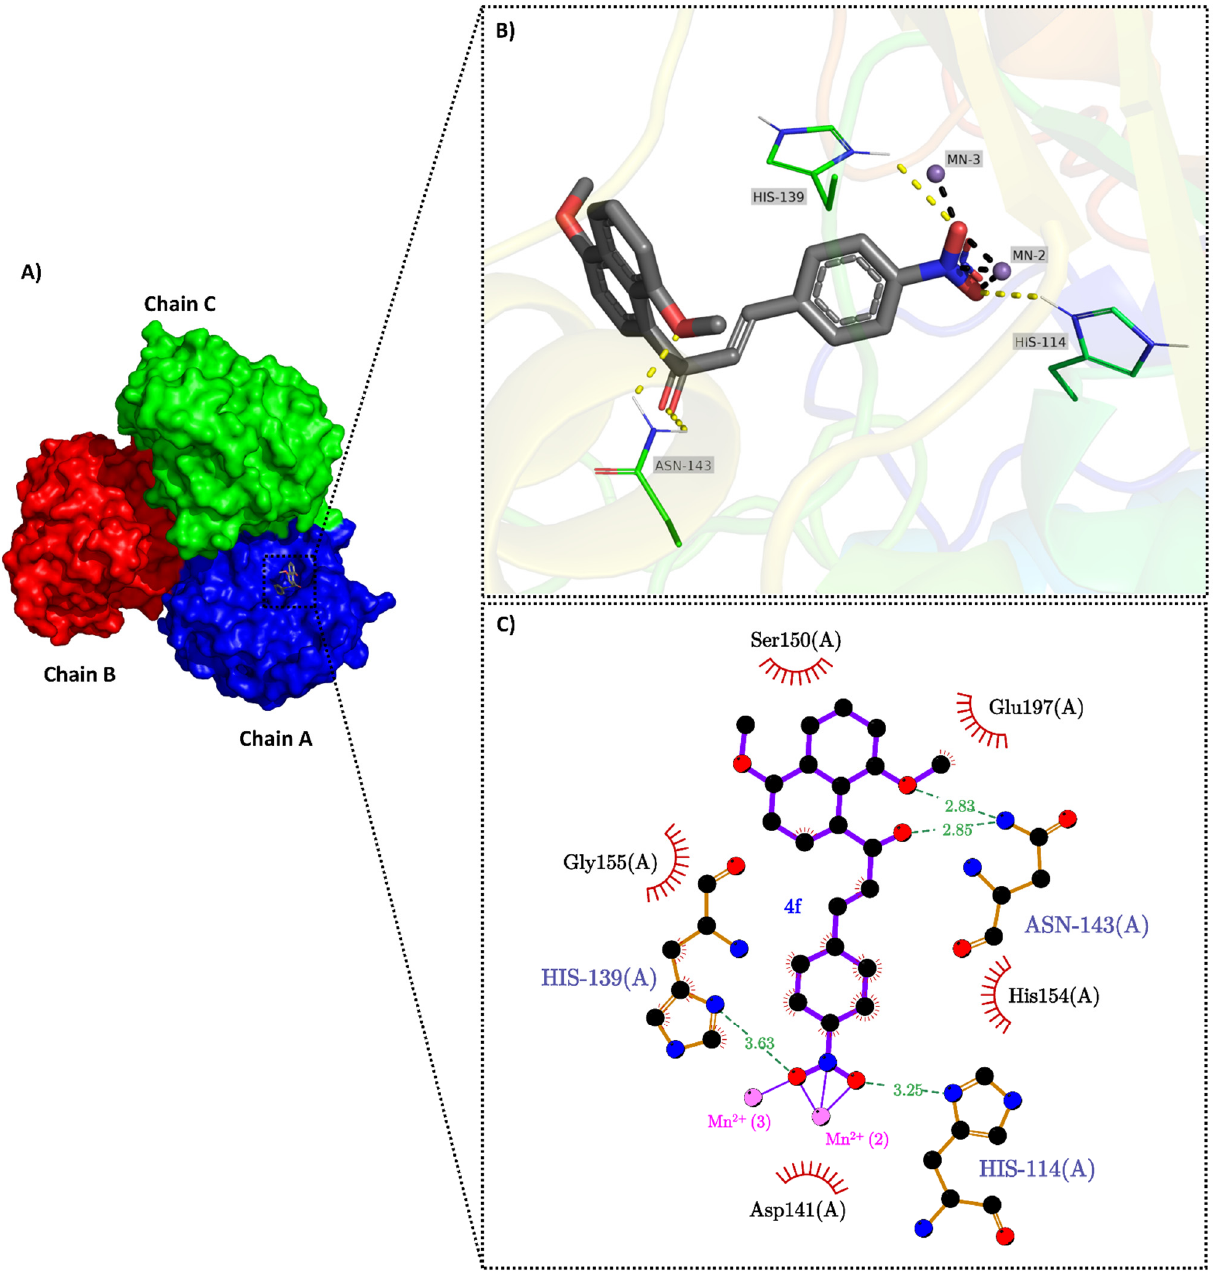
Figure 9. Protein-ligand interactions. ( A ) Surface representation of the trimeric form of ARG. Chain A is blue, chain B is red, chain C is green, and ligand 4f is presented as gray sticks. ( B ) An enlarged view of the substrate-binding pocket. Residues interacting via hydrogen bonding are shown in lines. The two manganese ions (Mn 2+ ) are shown as purple spheres. The hydrogen bonds with the ligand 4f are shown as yellow dashed lines, and the interaction with the metal is shown as the black dashed line. ( C ) 2D representation generated by LigPlot+ of probable interactions between compound 4f and residues from the catalytic domain of ARG. Purple lines indicate interactions with Mn 2+ ions. Green dashed lines represent hydrogen bond interactions. The arcs with spokes represent non-ligand residues involved in hydrophobic contacts.